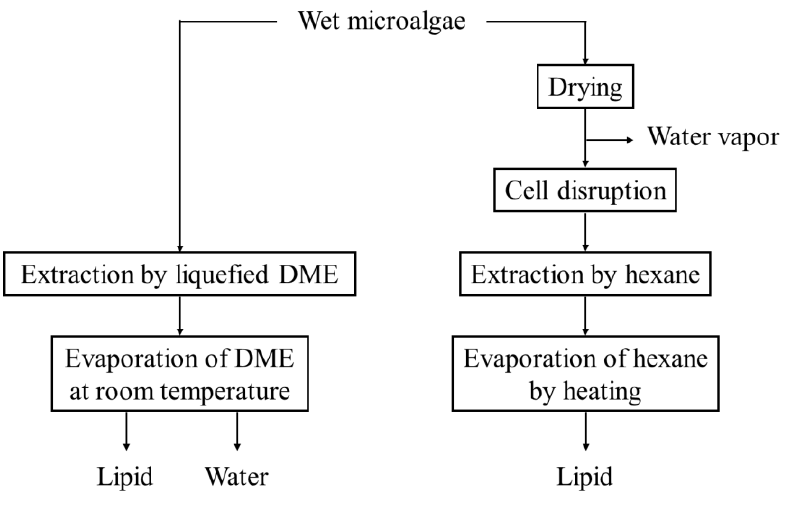
Figure 3. Comparison of the liquefied DME and typical hexane extraction